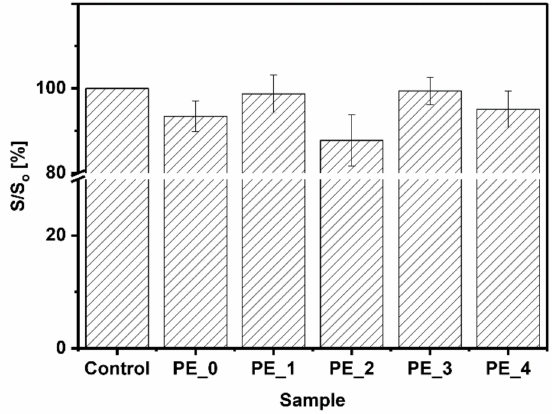
Figure 7. Cytotoxicity test results represented as survivability of cells (in